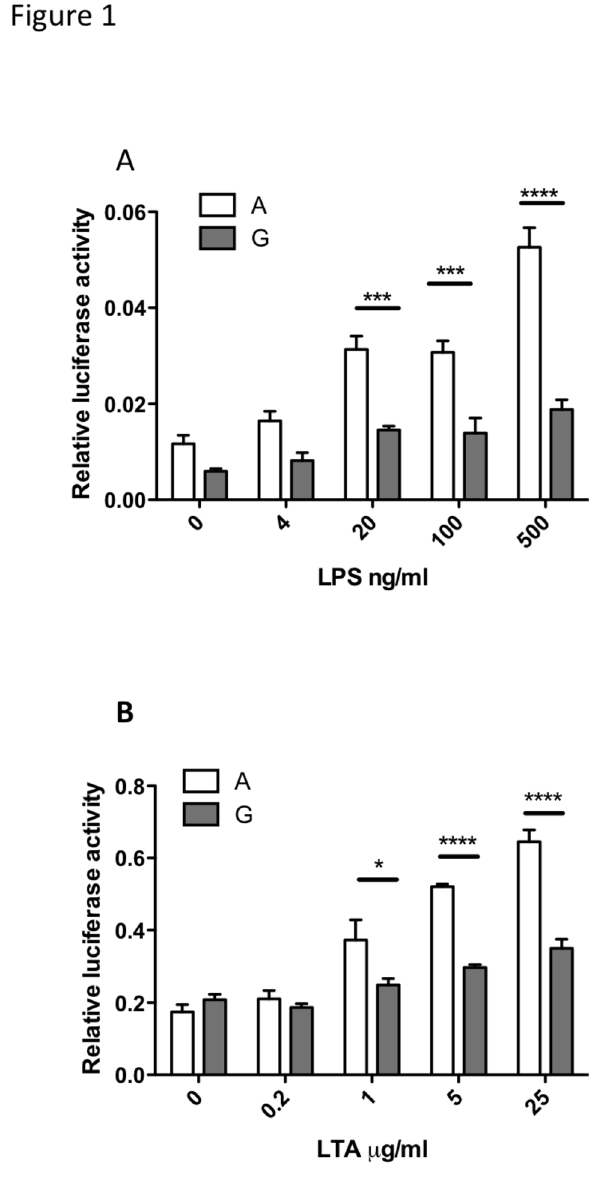
Figure 1. TNF promoter containing the ‘A’ variant of rs361525 has an augmented response to TLR4 and TLR2 ligands, compared to the -238G variant. Raw 264.7 cells were transiently transfected with firefly-luciferase reporters under the control of the ‘A’ or the ‘G’ variants of the TNF promoter, and co-transfected with a constitutive Renilla- luciferase reporter. Transfected cells were stimulated with the stated concentration of lipopolysaccharide (LPS, TLR-4 ligand; panel A ) or Lipoteichoic acid (LTA, TLR-2 ligand; panel B) for 6 hours. A representative of four experiments is shown. Results were analyzed by two-way ANOVA with a Bonferroni